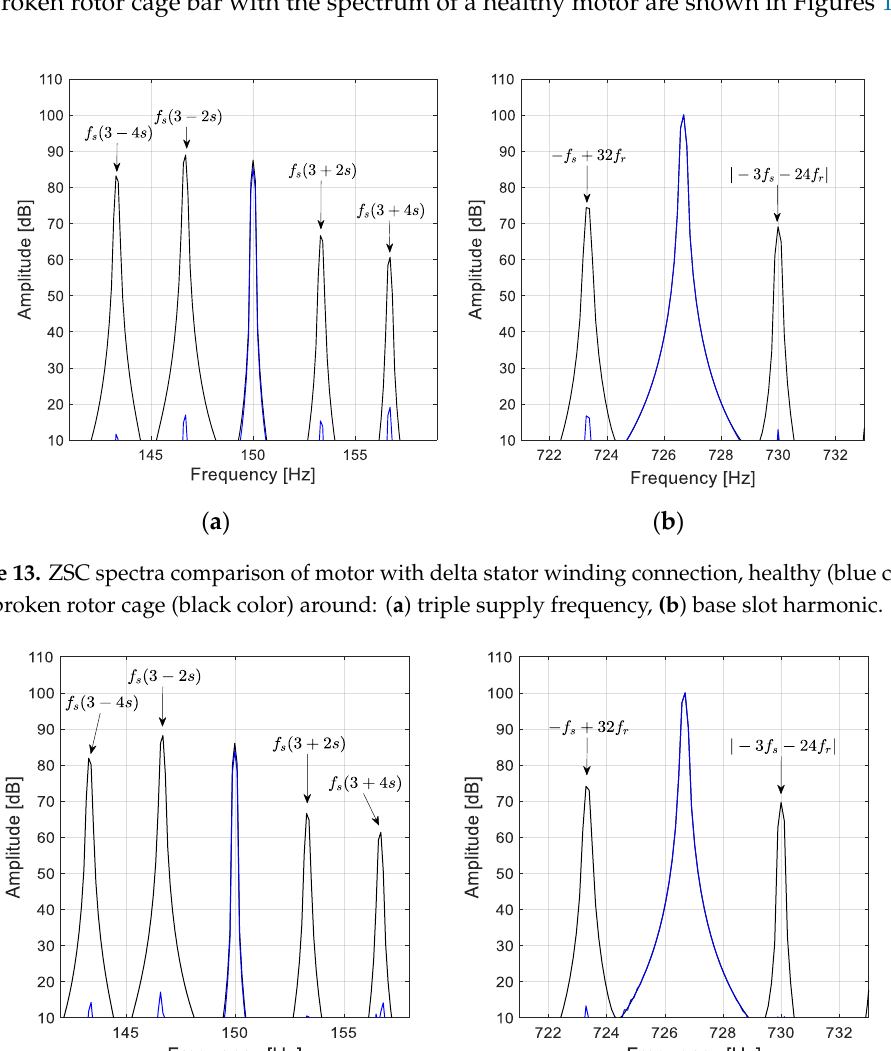
( b ) Figure 12. ZSC spectrum of motor with broken rotor cage bars for the stator winding connection: ( a ) delta connection; ( b ) wye connection with neutral wire.